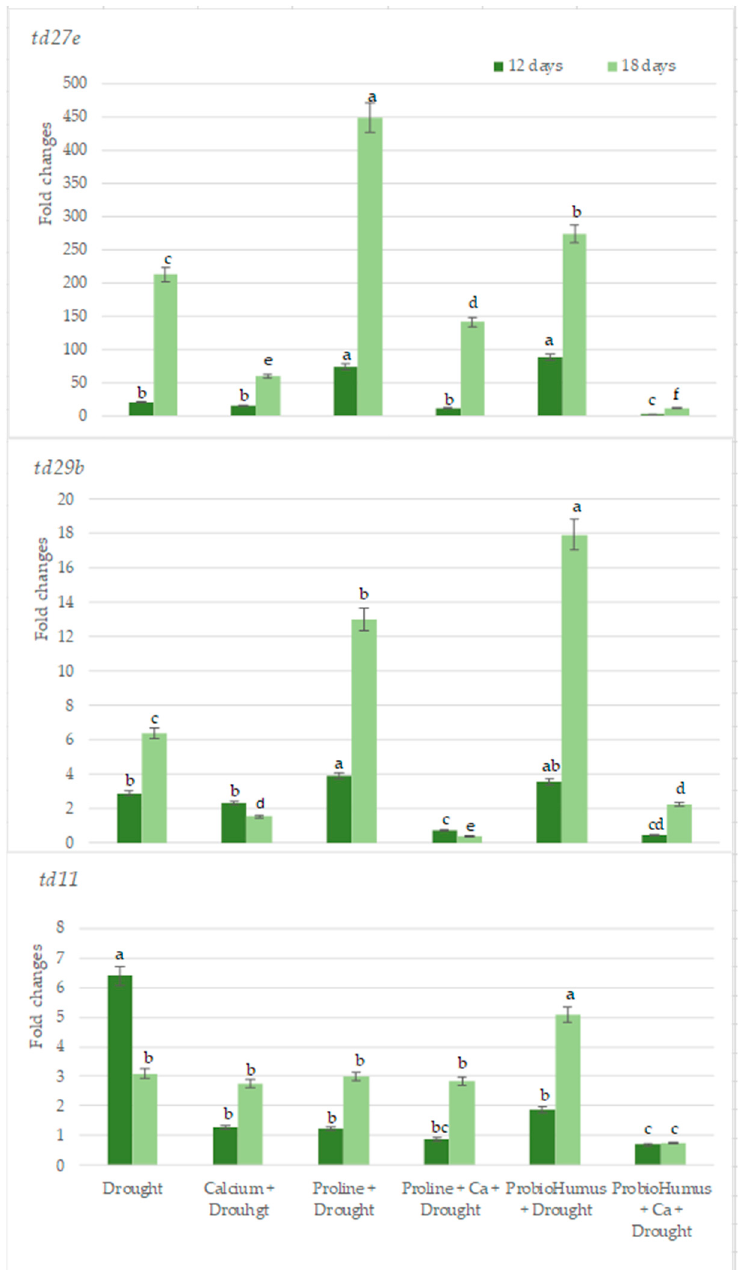
Figure 7. The effects of stress-protecting compounds application and prolonged drought stress (12 and 18 days) on winter wheat lea genes ( td27e , td29b , td11 ) expression level. Error bars represent the standard deviation of the mean. Control, Ca, proline, proline + Ca, ProbioHumus, and ProbioHu- mus + Ca indicates the type of application. Different lowercase letters in the same day of drought indicate statistically significant differences ( p < 0.05).